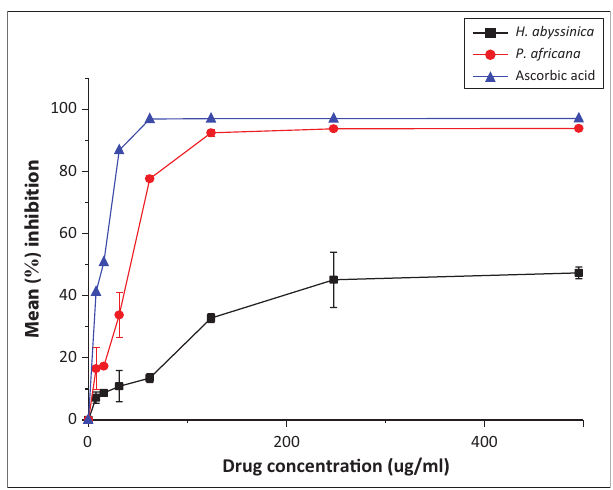
FIGURE 7: Antioxidant activity of Prunus africana and Harrisonia abyssinica methanolic extracts.